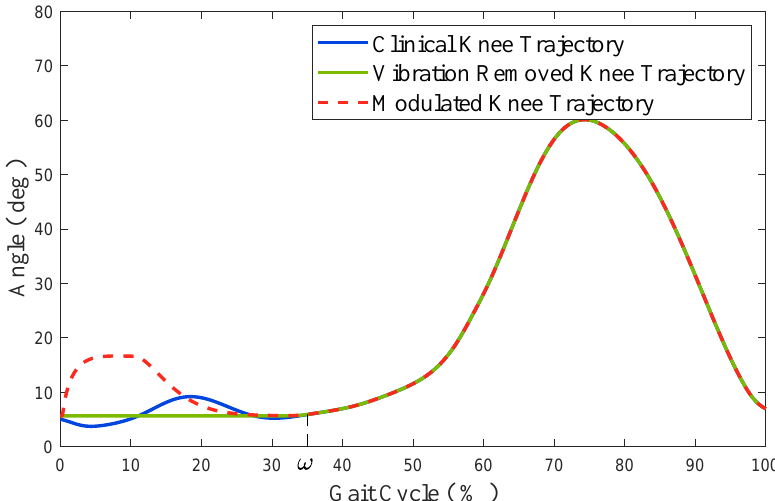
Figure 4. The typical clinical knee-trajectory, vibration-removed knee trajectory, and modulated knee trajectory. After swing-feet strikes, the modulated knee trajectory has a larger amplitude to mimic the OSAM, and returns to the clinical knee trajectory after the shock absorption.